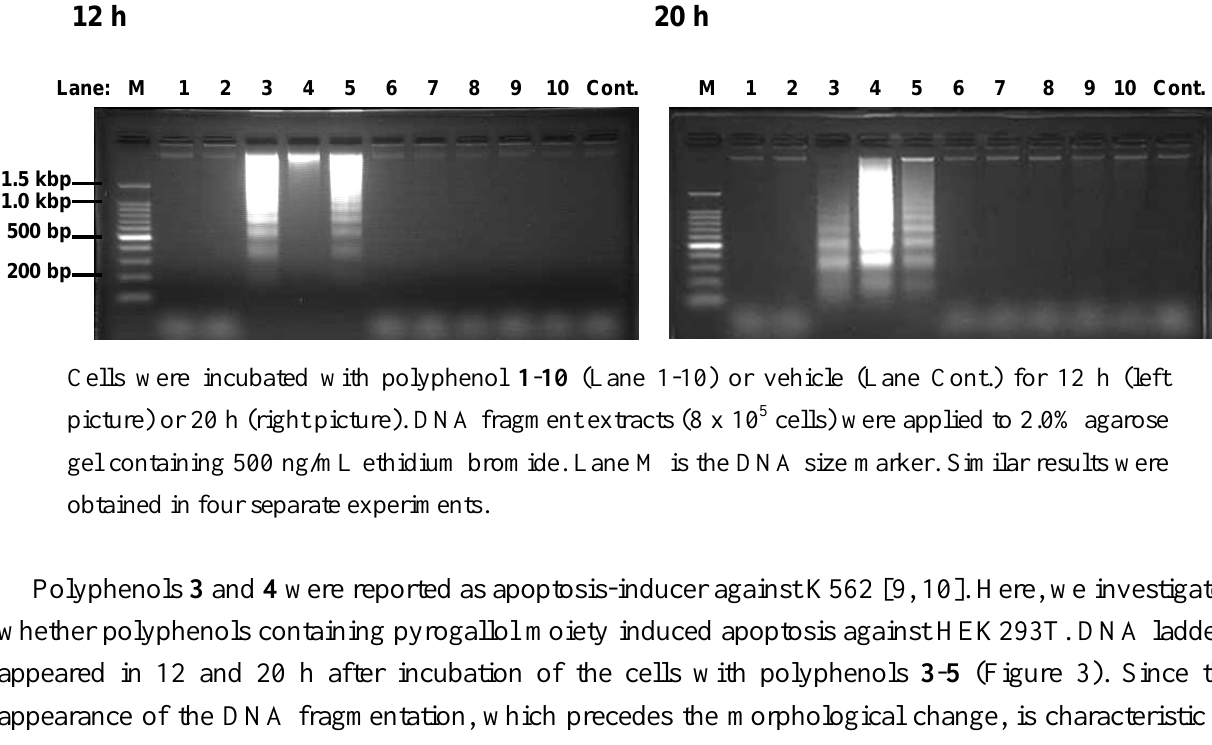
Figure 3. DNA fragmentation of HEK293T cells induced by Compound